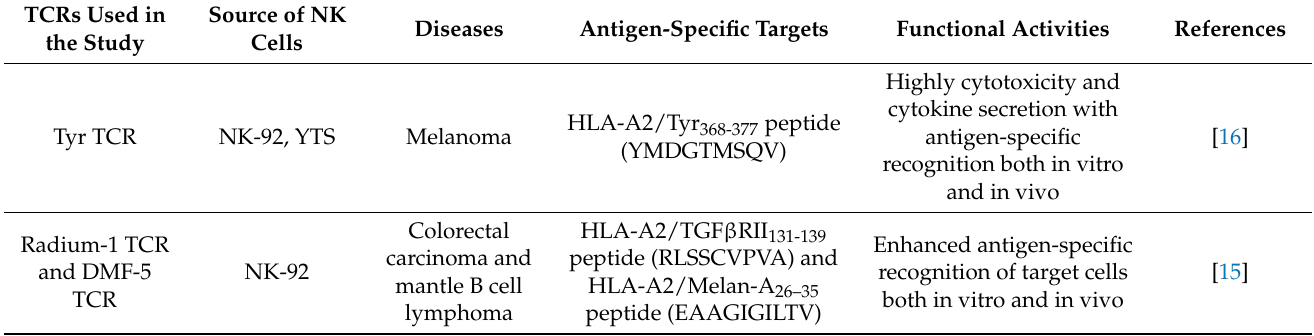
Figure 2. Genetic modifications of NK-92 cells with TCR for cancer immunotherapy. Tumor-specific TCRs are generated from the tumor-specific TCR library. TCRs are constructed into a lentivirus vector. The lentiviral particles of TCR are produced by transfection with the TCRs lentivirus vector into packing cells (293T cell). To make a stable expression of TCR and CD3 in NK-92 cells, the NK-92 cells are transduced with the lentiviral particles of CD3 (NK-92-CD3). Then, the stable expression of NK-92-CD3 is transduced with lentiviral particles of TCR (TCR-NK-92-CD3, in the short term called TCR-NK). The positive TCRs expressing in NK-92 cells are expanded ex vivo. TCR-NK products are manufactured under GMP-compliant conditions (e.g., irradiated cells prior infusion to patients). The final products of TCR-NK are infused into patients. Table 3. TCR-NK cell-based therapy in pre-clinical